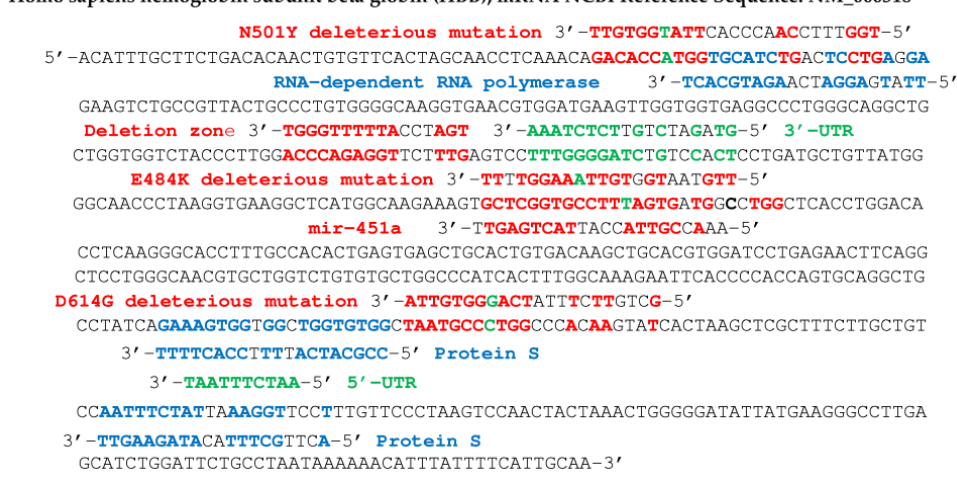
Figure 7. Human hemoglobin beta-subunit (HBB) gene potentially targeted by SARS-CoV-2 gene fragments from RNA-dependent RNA polymerase, protein S and deletion zone (in blue), and by the human miR hsa miR 451a (in red). Some fragments in red contain deleterious mutations of protein S: N501Y, E484K and D614G (base mutated in green) and in green come from 5 ′ - and 3 ′ -UTR parts of SARS-CoV-2 genome. Probability of hybridization by chance of length 8 (resp. 10) in a sequence of 624 nucleotides equals 0.04 (resp. 0.005), hybridizations T-G and G-T counting for ½ .